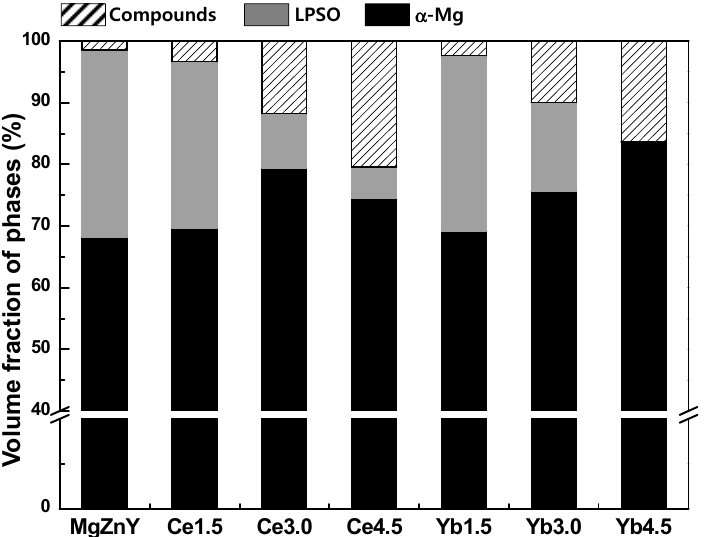
Figure 11. Volume fraction of the α -Mg, LPSO phases, and compounds in Mg-Zn-Y-RE alloys. The negative mixing enthalpy between Mg-RE and Zn-RE as well as the difference in the atomic sizes of Mg, Zn, and RE were similar for the addition of Ce and Yb. However, the solid solubility limits of Ce and Yb in magnesium are 0.66 and 3.3 wt.%, respectively, at the eutectic temperature [14]. The high solid solubility limit of Yb lowered the volume fraction of the intermetallic compounds in the Mg-Zn-Y-Yb alloy; however, the effect on the volume fraction of the LPSO phases was negligible at a Yb content of 1.5 and 3.0 wt.%. Therefore, the volume fraction of the LPSO phases in the Mg-Zn-Y-Yb alloys was higher than that of the LPSO phases in the Mg-Zn-Y-Ce alloys. The LPSO phases were absent in Mg 88.5 Zn 5 Y 2.0 Yb 4.5 . The XRD analysis indicated that Zn and Y formed a compound,